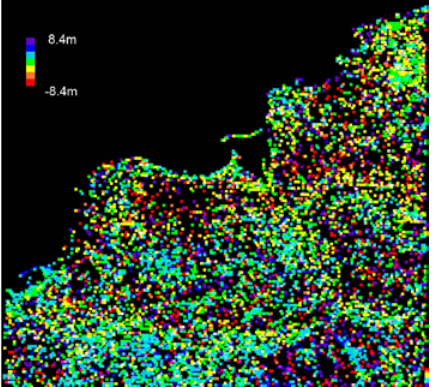
Fig. 17: Color coded height differences Pléiades DSM